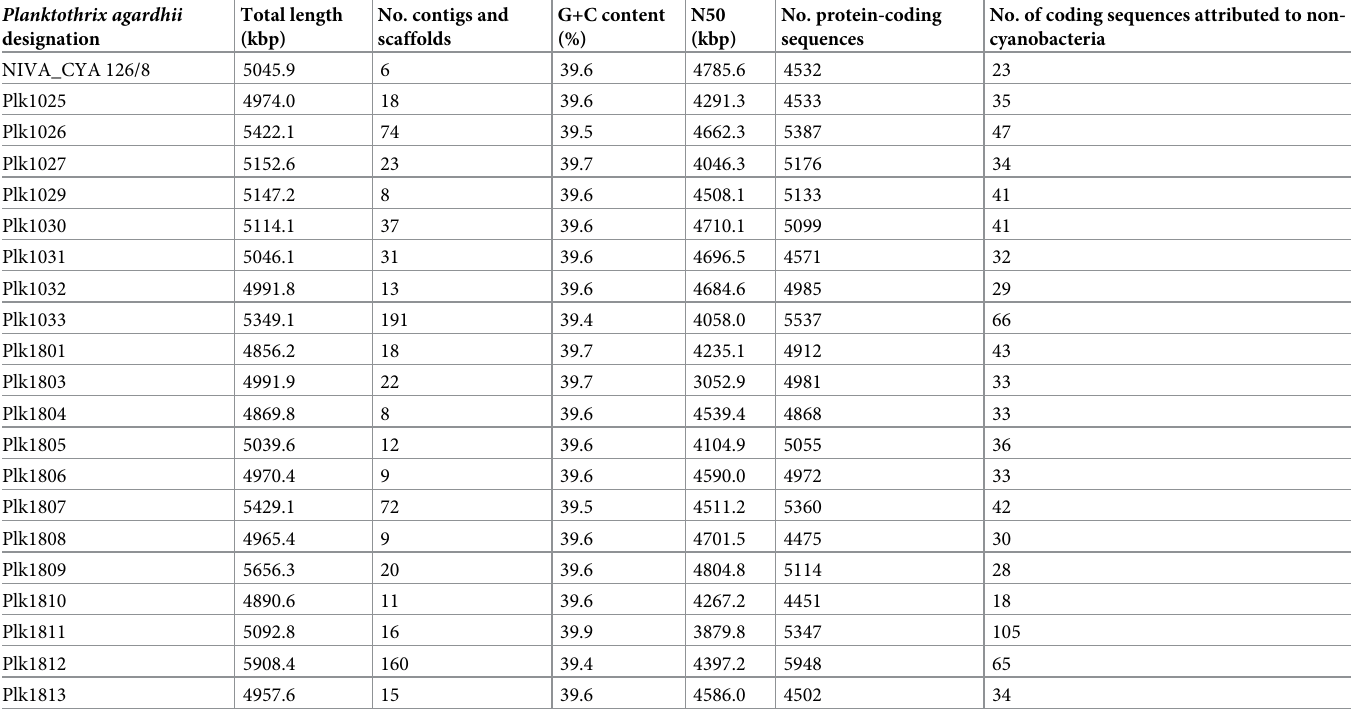
Table 1. Genome characteristics for Sandusky Bay Planktothrix agardhii isolates and reference sequence Planktothrix agardhii NIVA_CYA 126/8. Planktothrix agardhii